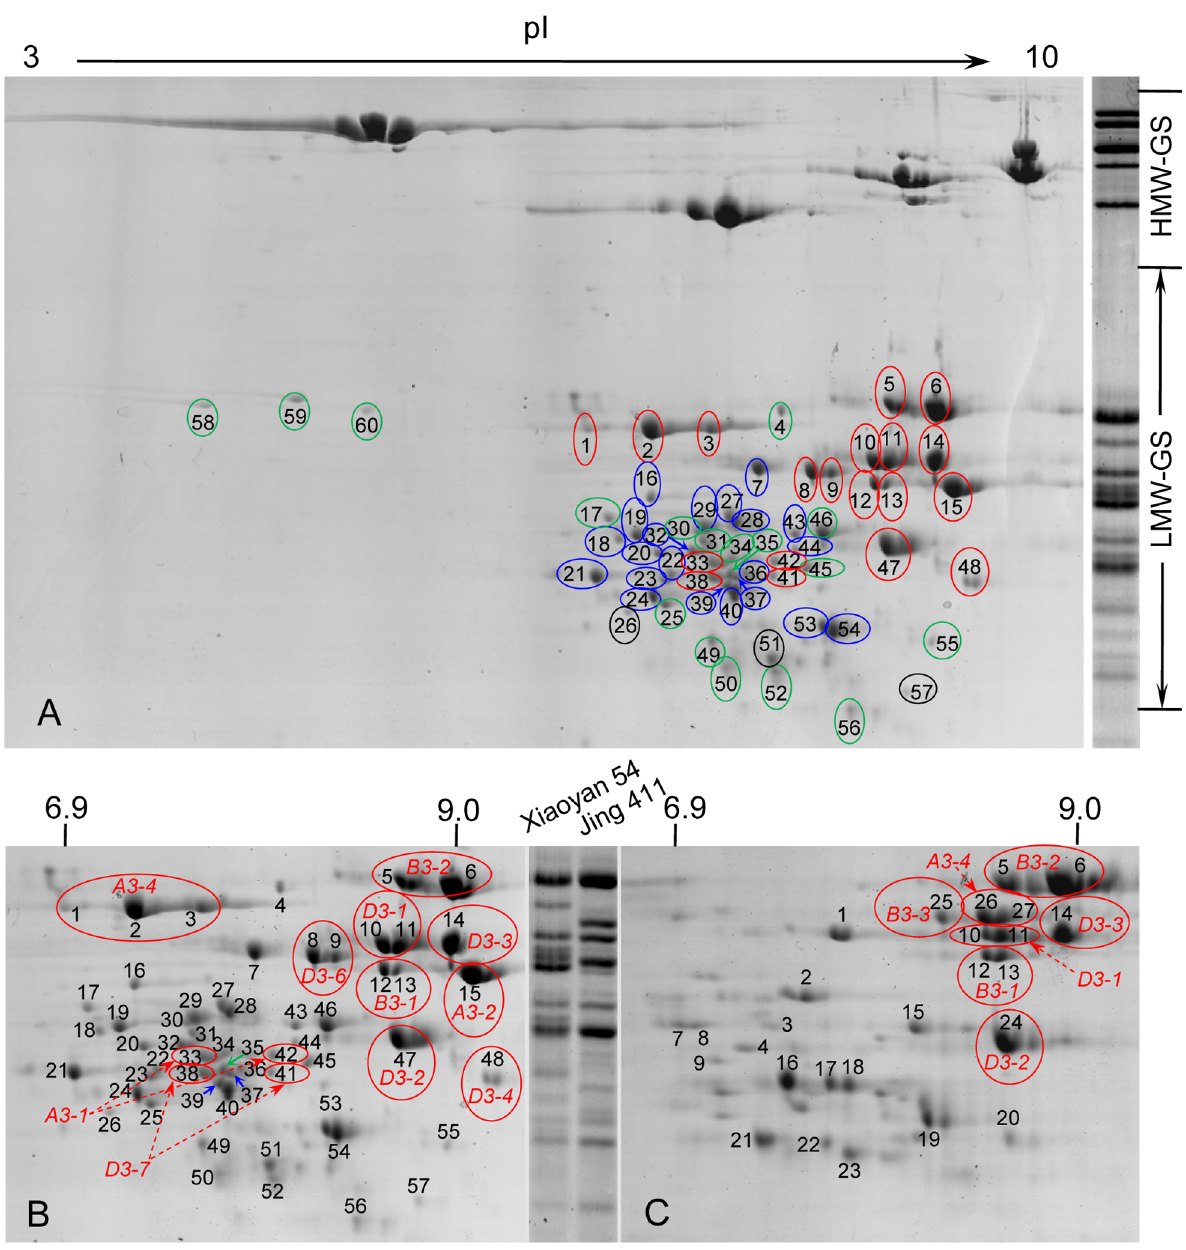
Figure 4. Identification of protein spots resolved by 2-DE of the glutenin samples. Glutenin fractions were prepared from mature grains, and used for 2-DE and subsequent MS analysis. For reason of space, the high molecular weight glutenin subunit protein spots are not shown. (A) Identification of 60 protein spots derived from the glutenin fraction of Xiaoyan 54. The LMW-GS and gliadin protein spots are circled in red and blue, respectively. Spots circled in black are known proteins with other molecular functions, whereas those in green are unknown proteins. The pI range in the 2-DE gel is shown at the top. Also shown (on the right side) is the one dimensional separation of the glutenin fraction of Xiaoyan 54. The data displayed are typical of four independent sets of 2-DE separation and MS analysis. (B, C) Comparisons of the LMW-GS protein species (circled in red) accumulated in the mature grains of Xiaoyan 54 (B) and Jing 411 (C). The names of the LMW-GS genes encoding the circled proteins are provided. For both varieties, the LMW-GS protein species were accompanied by some gliadin protein species and the proteins with other or unknown functions (represented by numbered but uncircled protein spots, Tables S4 and S6). The pI ranges in the 2-DE gels are displayed at the top. The one dimensional separation results of the glutenin fractions of the two varieties are also shown (labeled by Xiaoyan 54 and Jing 411, respectively). The data provided are representative of four independent sets of 2-DE separation and MS analysis. doi:10.1371/journal.pone.0013548.g004 spots and the deduced amino acid sequences of the 11 active summarized in Table 2 and Figure 4B. The phenomenon that two or three protein spots were matched to the deduced protein of a LMW-GS genes isolated in this work (Table S5). Based on these comparisons, the relationships between the analyzed protein spots single LMW-GS gene (e.g., protein spots 1, 2 and 3 to A3-4 ) was and the proteins deduced from the cloned LMW-GS genes are observed previously, although the underlying reasons are still